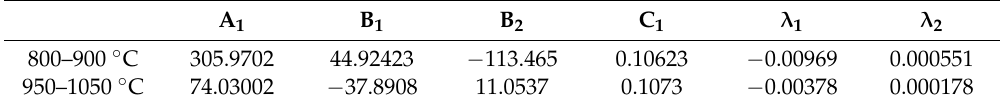
Table 2. The parameters of the modified Johnson-Cook model for Ti-6Al-4V